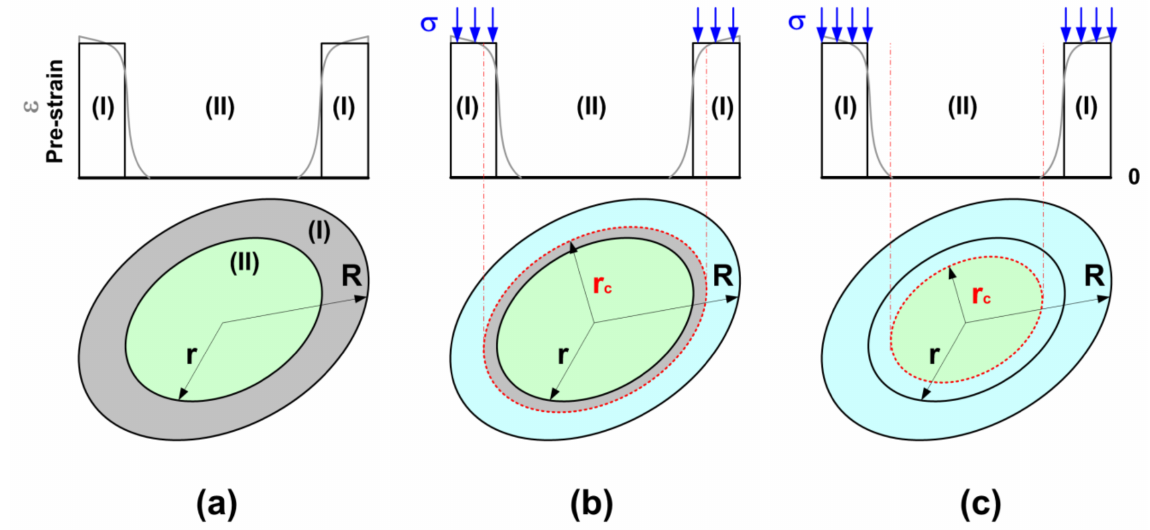
Figure 4. Illustration of cross-section of dried fiber and pre-strain in it. ( a ) Before wetting; ( b ) buckling when the shell is partially wetted; ( c ) buckling when the core is partially